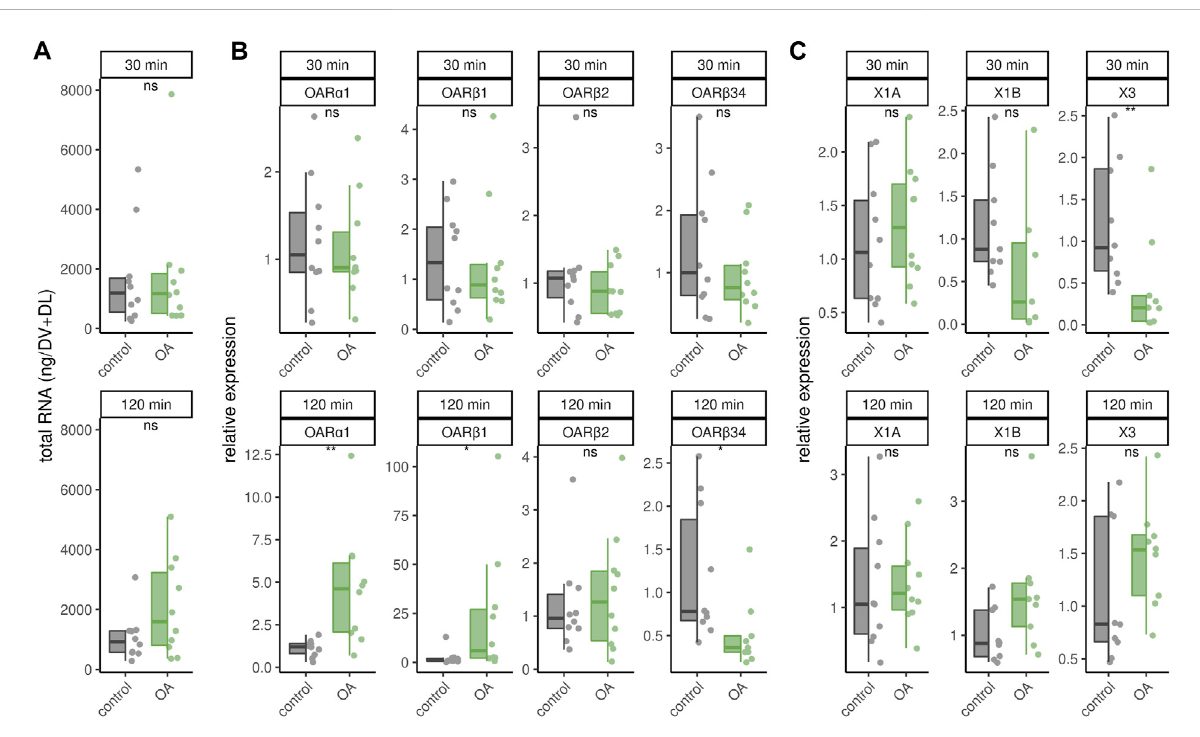
FIGURE 5 Effects of octopamine injections. Workerbees received octopamine injections in their fl ight muscles. After 30 and 120 min we measured RNA total concentration (A) , octopamine receptor gene expression (B) and AmOAR β 2 isoform abundance (C) . * = p < 0.05, ** = p < 0.01, ns = p ≥ 0.05, Mann-Whitney U test. For each group/data-set median ± IQR (left part) and individual data points (right part) are shown. For detailed statistics please see Table